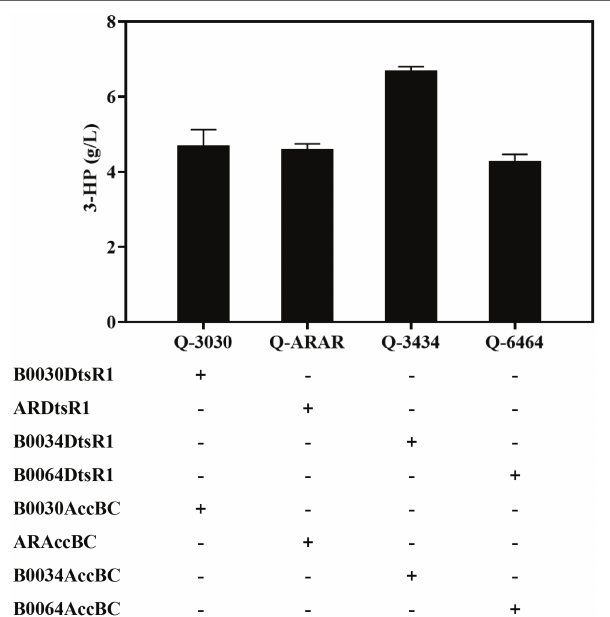
FIGURE 6 | Balance of Acc and MCR expression levels for improving 3-HP production in a producing strain Q2098. Four levels of Acc (strains Q-3030, Q-ARAR, Q-3434, and Q-6464) were controlled by substituting RBSs of various strengths. 3-HP was detected in 48 h. All results were calculated with three ( n = 3) independent replicates.